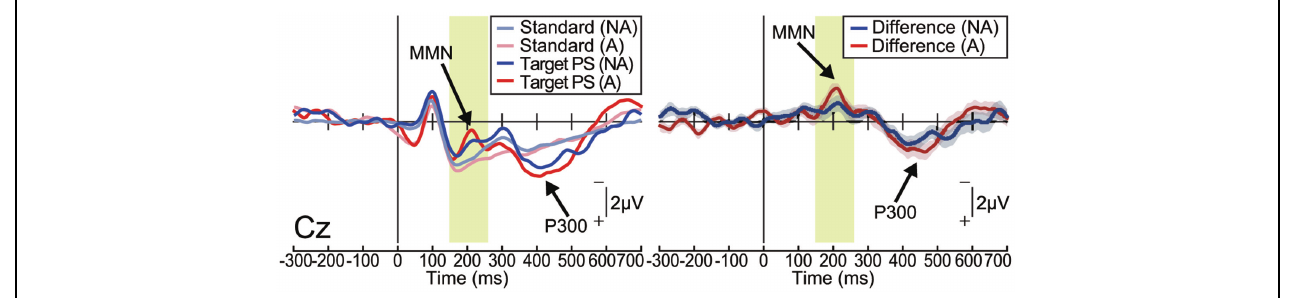
FIGURE 2 | Pitch-deviant auditory feedback elicited MMN and P300 (Experiment 1). Left: the event-related potentials (ERPs) at Cz elicited by pitch-deviant stimuli presented passively (non-action condition; NA) or by a mouse-click performed by the participant (action condition; A; n = 16). Right: differential (target – standard) ERP waveforms. Shaded (blue or red) areas represent SEM. The MMN was observed around 200 ms from the stimulus onset, both in the non-action [ t ( 15 ) = 4.84, P < 0.001, effect size r = 0.78] and action conditions [ t ( 15 ) = 6.20, p < 0.001, effect size r = 0.85]. The P300 followed the MMN [non-action: t ( 15 ) = 9.07, p < 0.001, effect size r = 0.92; action: t ( 15 ) = 6.02, p < 0.001, effect size r = 0.84].